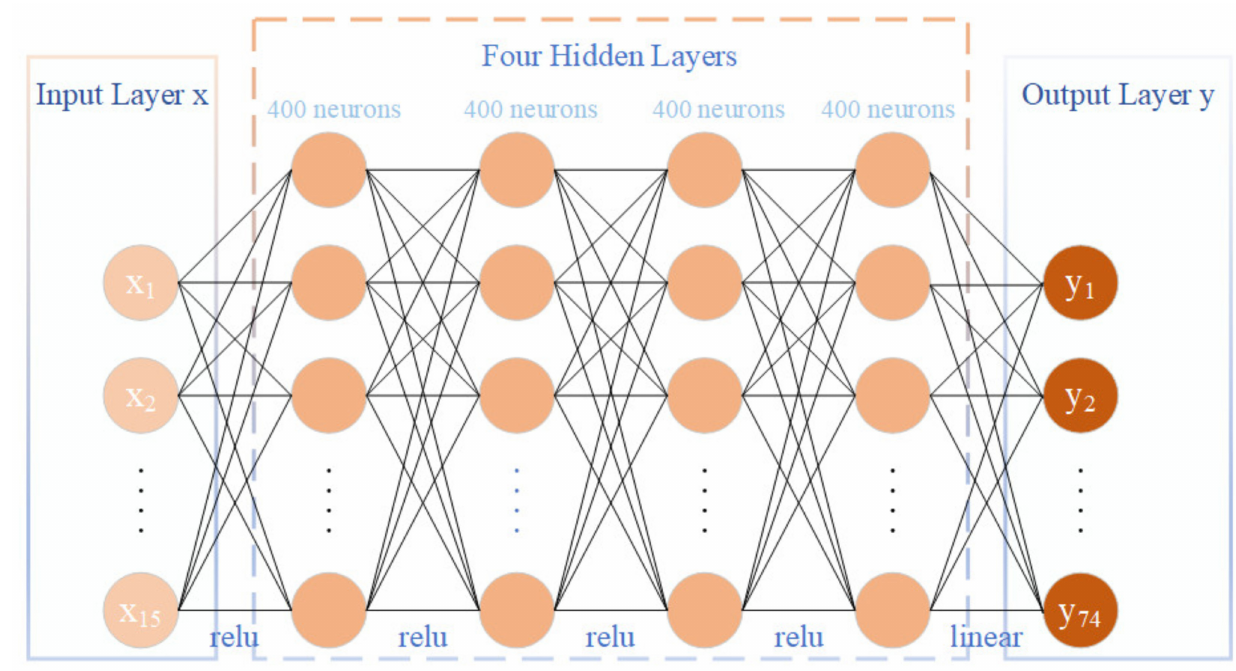
Figure 2. The DNN network